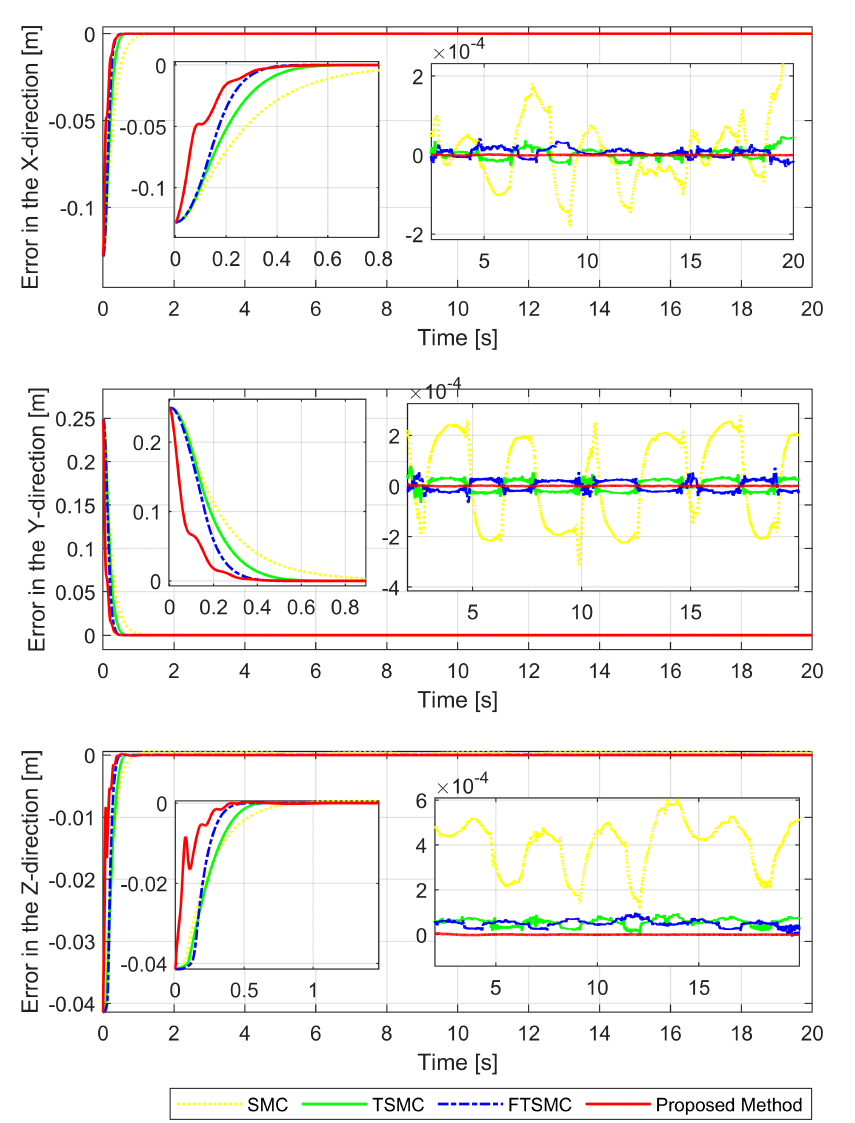
Figure 8. X-axis, Y-axis, and Z-axis error comparisons between the position of the end effector and the reference